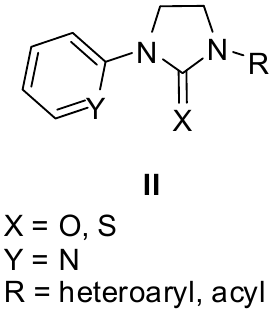
Figure 1. N -aryl(heteroaryl)ureas ( I ) and their cyclic analogues II